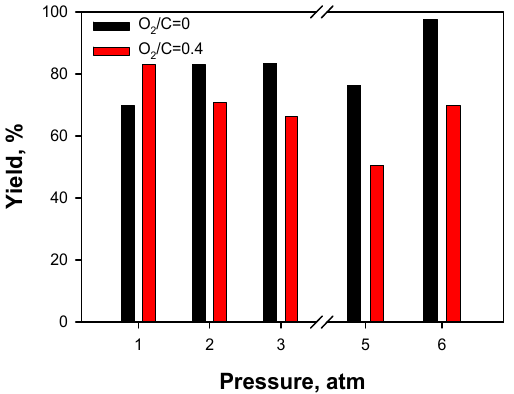
Figure 10. Gas yield as a function of pressure during steam reforming of AZ mixture on 5 Ni monolith at 720 °C; gas-phase feed composition: Solvent/H 2 O/O 2 /N 2 = 0.7/6/0/93.3; 0.7/6/0.8/92.5.